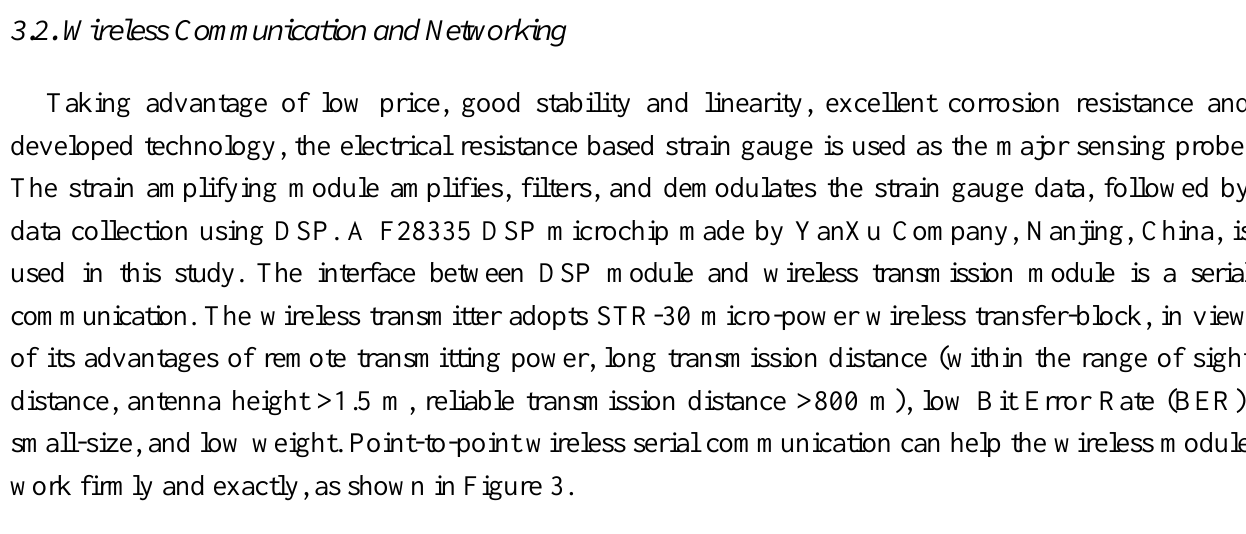
Figure 3. Point-to-point wireless serial